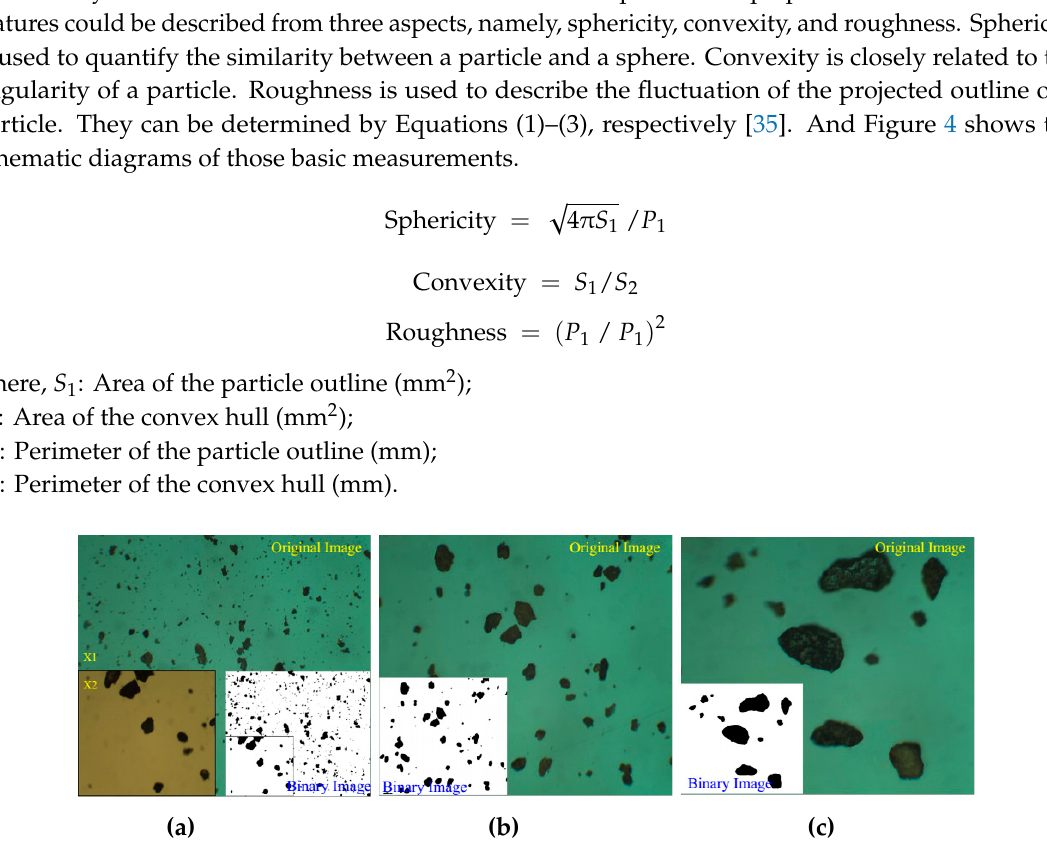
Figure 3. Tailings particle shape from the microscopic perspective. ( a ) silt clay; ( b ) silt sand ( c ) fine sand.